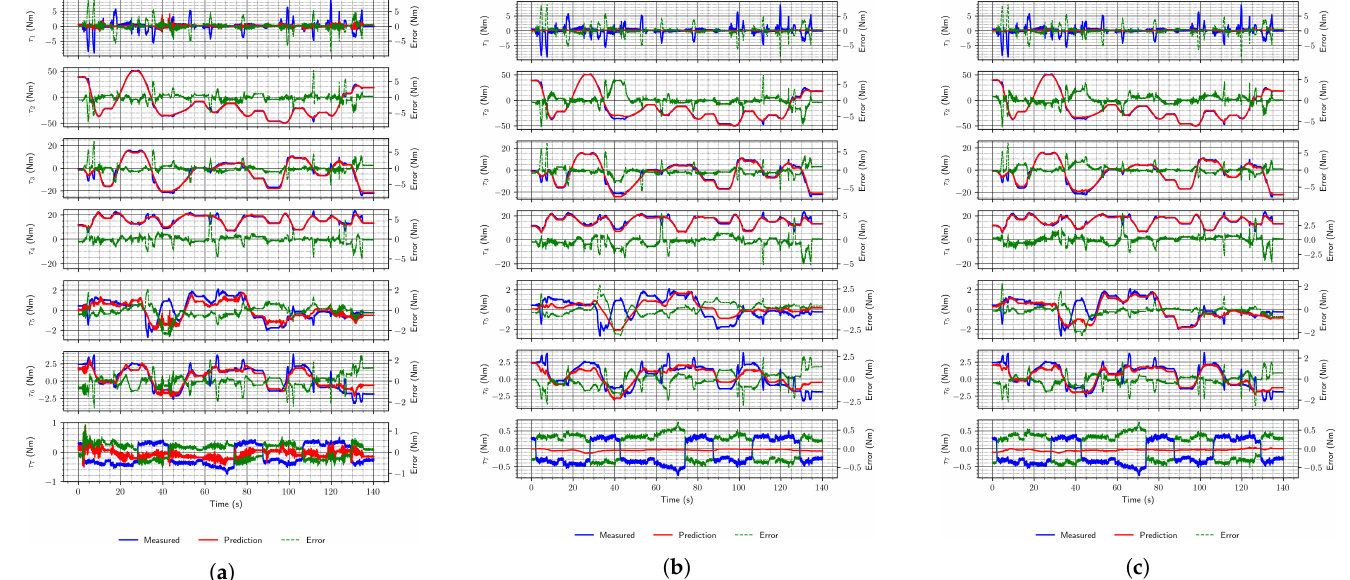
Figure 10. Example torque estimates on the real-world data sets. ( a ) DeLaN; ( b ) convolutional network; ( c ) LSTM